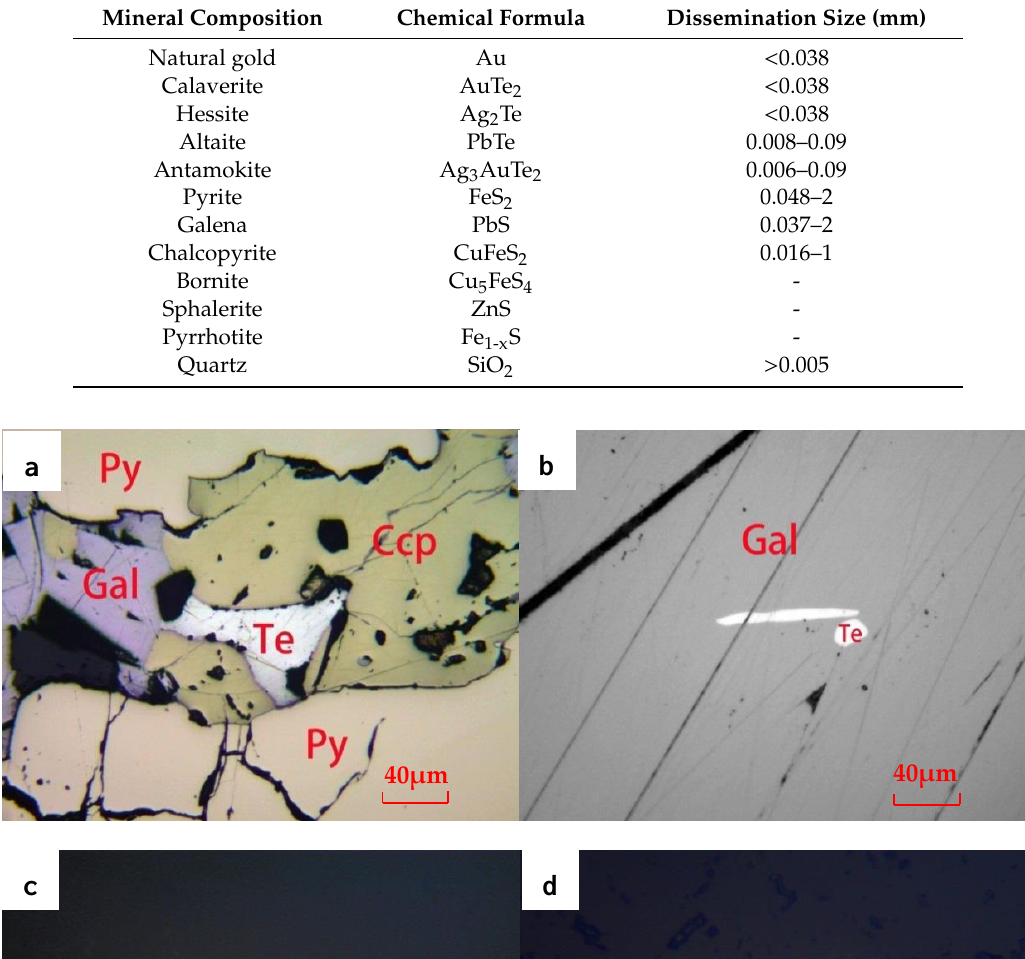
Table 1. Mineral composition, chemical formula, and dissemination size of the raw ore. Mineral Composition